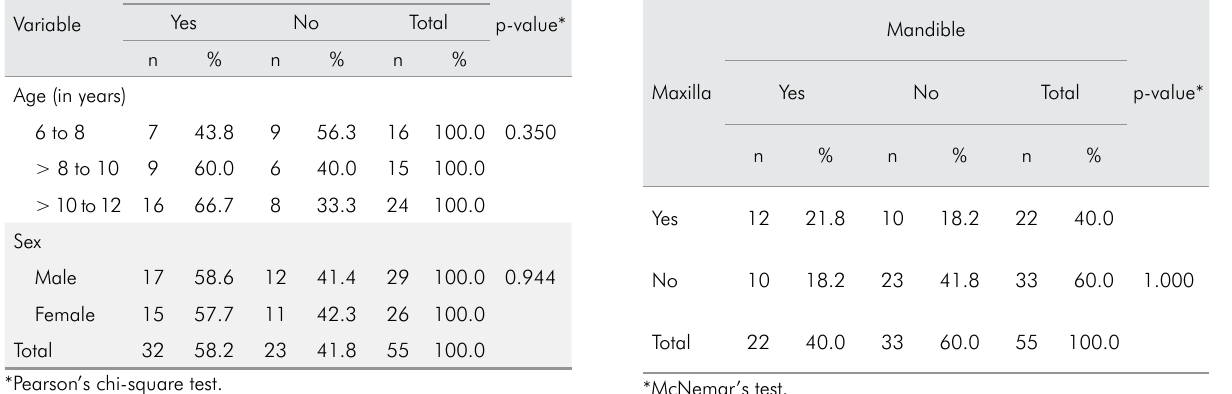
Table 2. Prevalence of enamel defects according to age and sex. Table 3. Prevalence of enamel defects between the jaws and dental